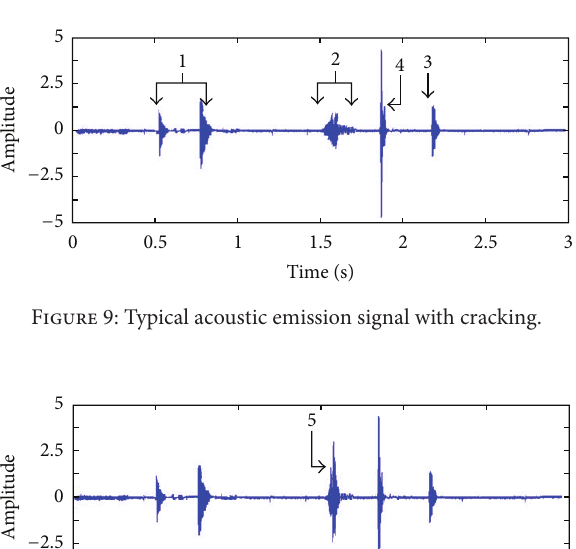
loading event (arrow 1 in Figure 9), nugget nucleation event (arrow 2 in Figure 9), electrode unloading event (arrow 3 in Figure 9) and cracking event (arrow 4 in Figure 9). The expulsion event is indicated as arrow 5 in Figure